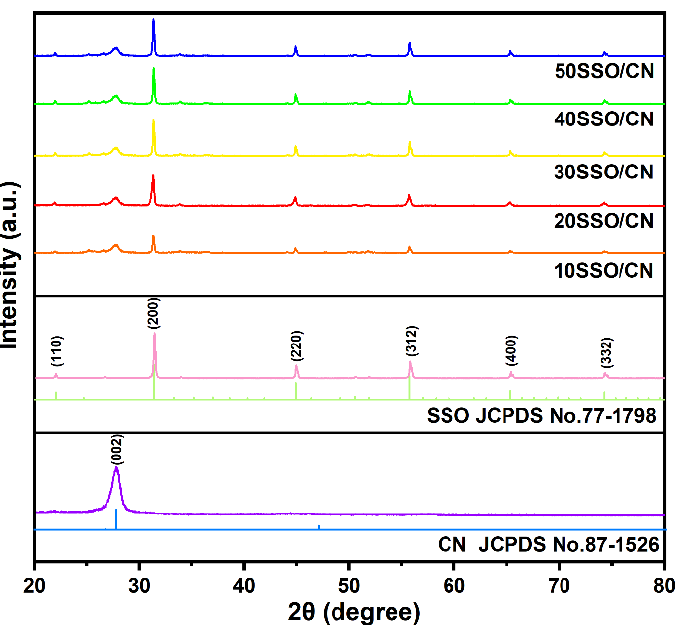
Figure 1. XRD patterns of CN, SSO, 10SSO/CN, 20SSO/CN, 30SSO/CN, 40SSO/CN, 50SSO/CN, and standard card.